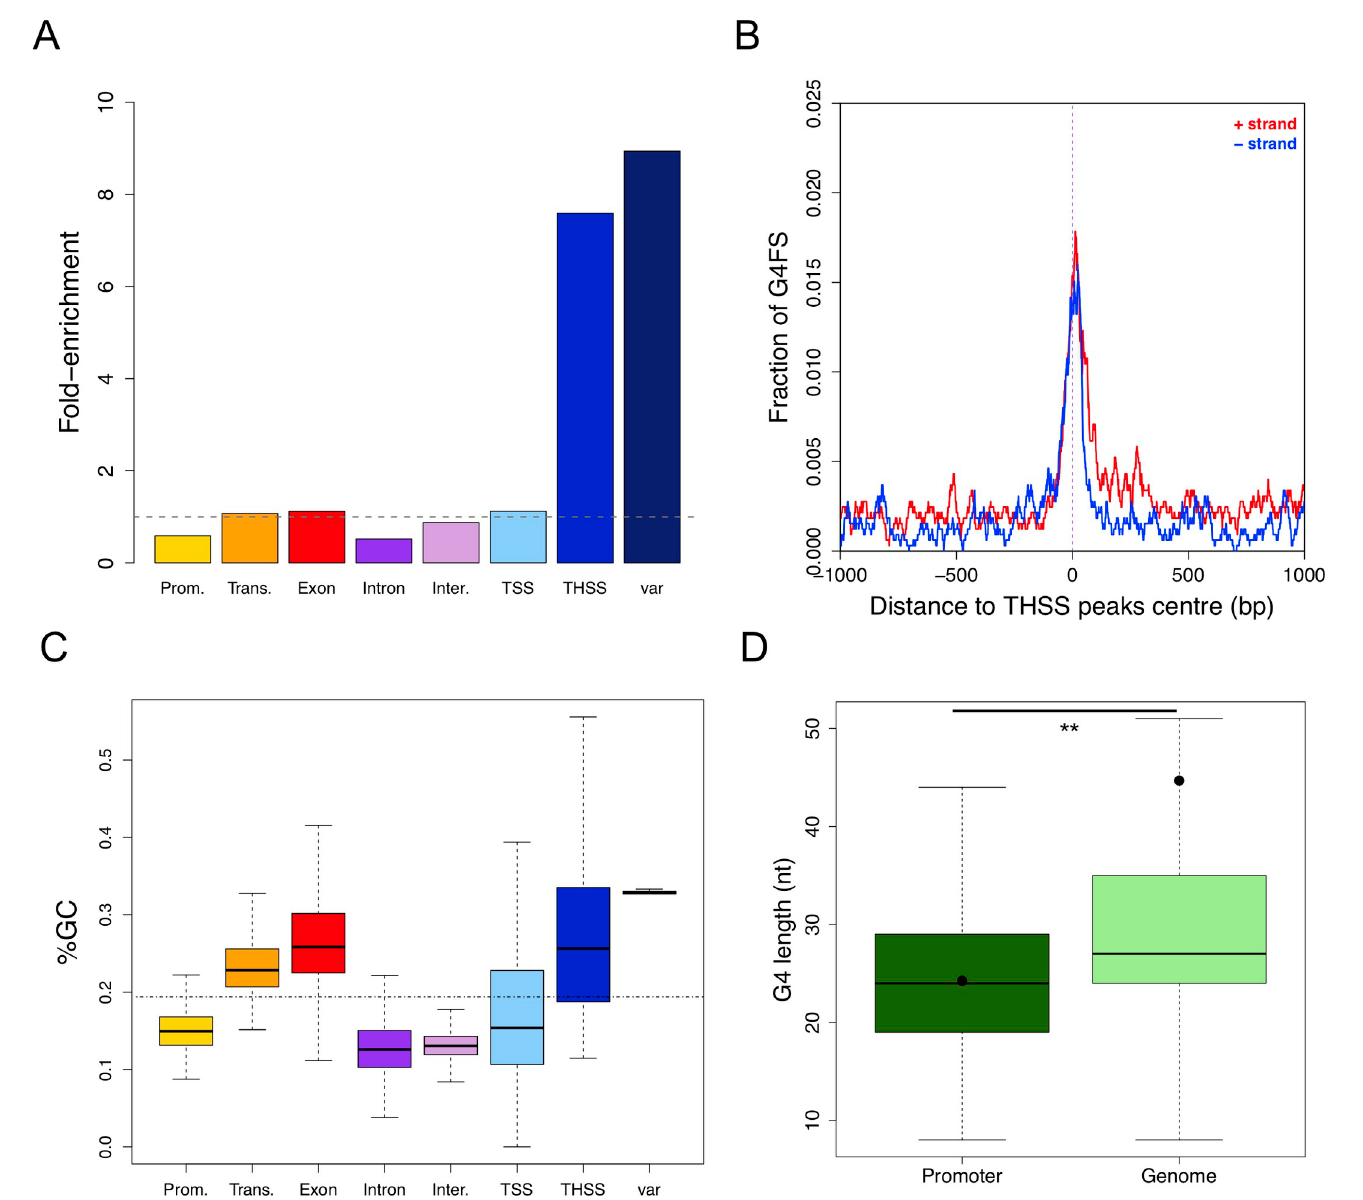
Fig 2. Association of G4FS with genome features of P . falciparum . (A) Fold-enrichment of G4FS in different genome features compared to 1,000 shuffling of G4H1.2 list. The dotted line indicates the fold-enrichment for the whole P . falciparum genome (value = 1.00). TSS: transcription start site. THSS: Tn5 hypersensitive sites. (B) Distribution profile of G4 motifs at threshold 1.2 around THSS peaks. The x-axis is centred on THSS peaks centre ± 1,000 bp. The red and blue lines correspond to G4FS on the coding and non-coding strands, respectively. (C) Boxplot representing the GC content in the different genomic features. The dotted line indicates the mean GC content of the P . falciparum genome. (D) Boxplot showing the G4 sequence length within promoters and in the whole genome. The mean sequence length (black point) of G4 within promoters was found significantly different from all G4 in the genome (two-tailed t -test, �� p -value <